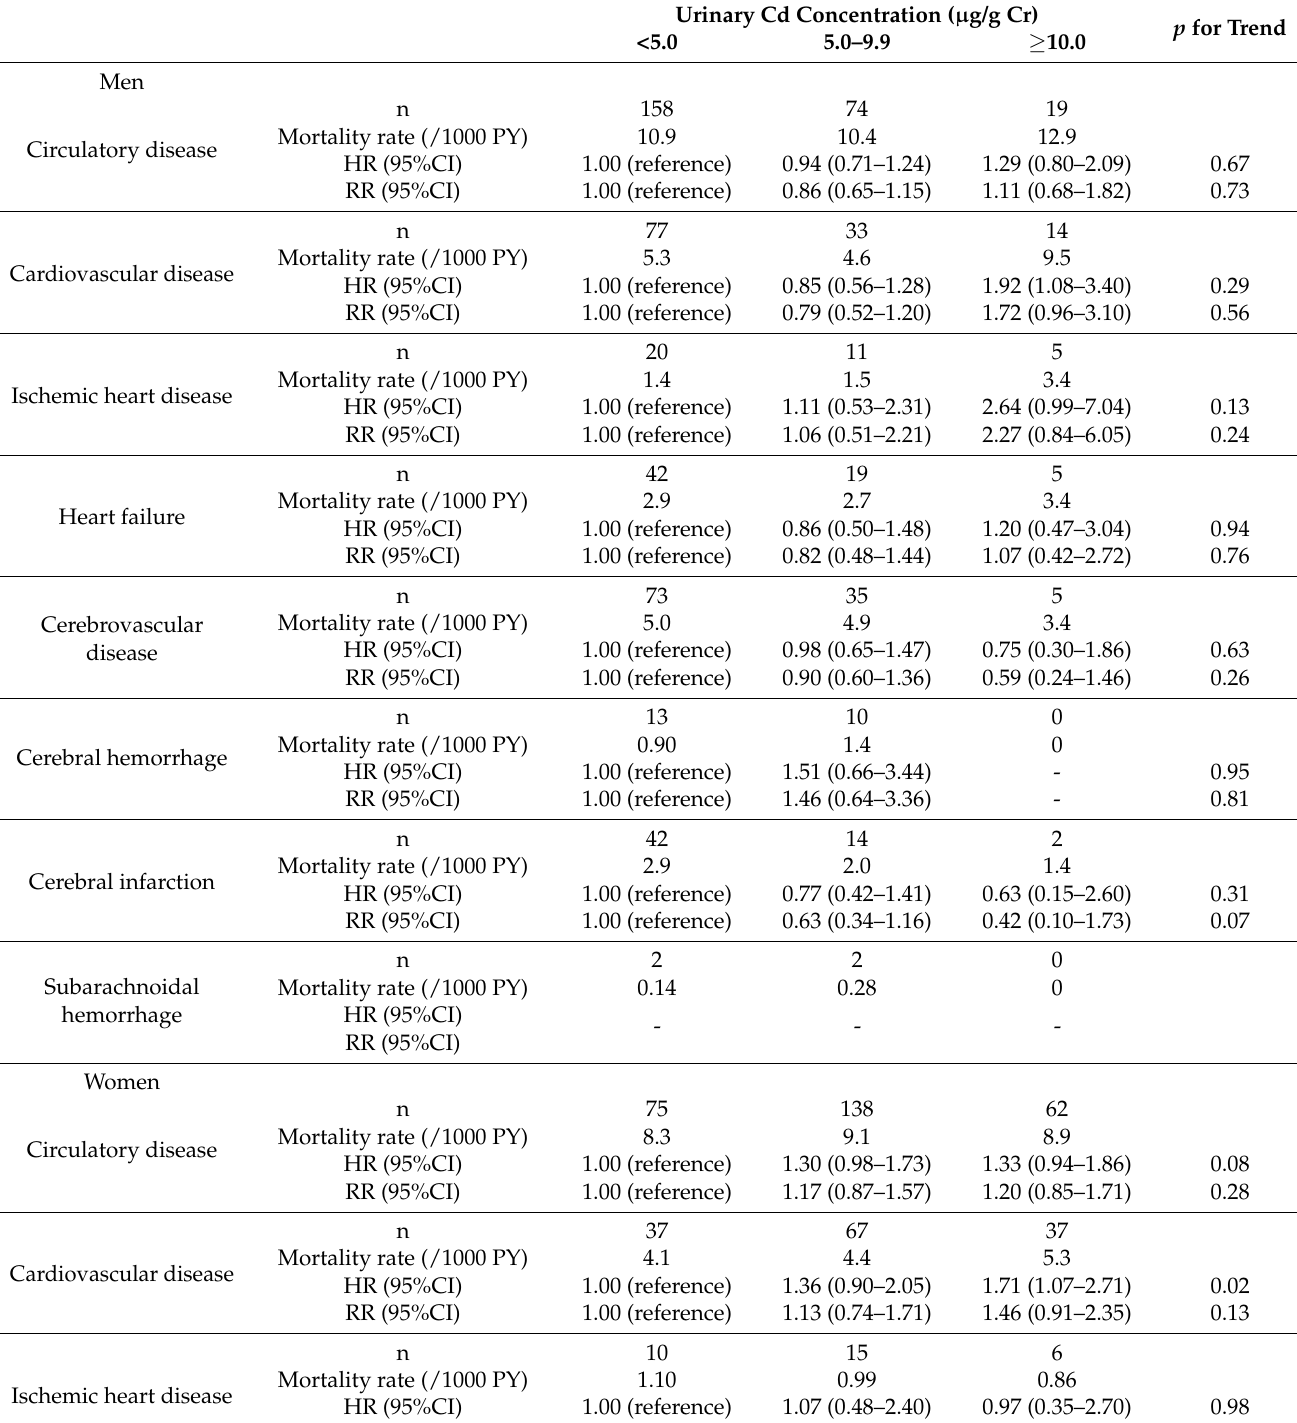
failure was significantly associated with urinary Cd concentration ( p for trend = 0.004) in the Cox regression model and remained statistically significant even after adjusting for the competing risks using the Fine and Gray regression model ( p for trend = 0.038). Table 4. Risk of mortality from circulatory disease according to the urinary Cd concentration in the participants with a urinary β 2-MG level less than 1000 µ g/g